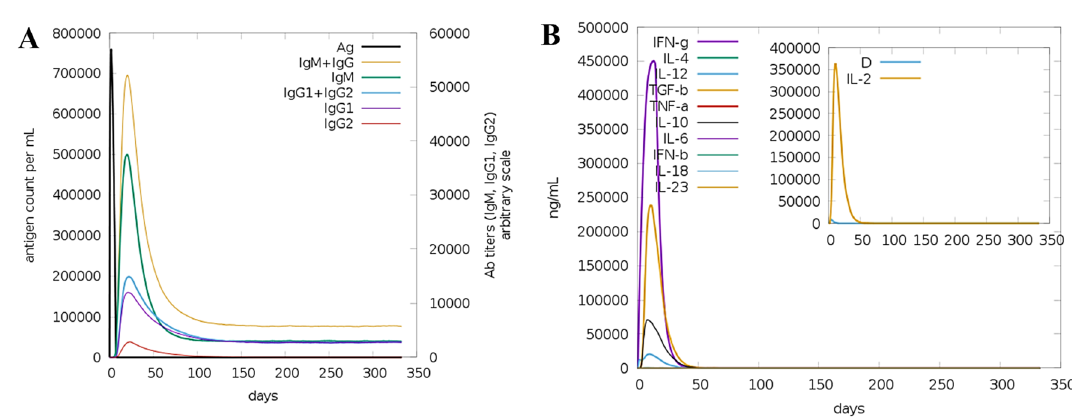
Figure 8. Simulated immune responses against the design vaccine antigen. ( A ) Antibodies titer count, ( B ) interleukin and interferon responses to the